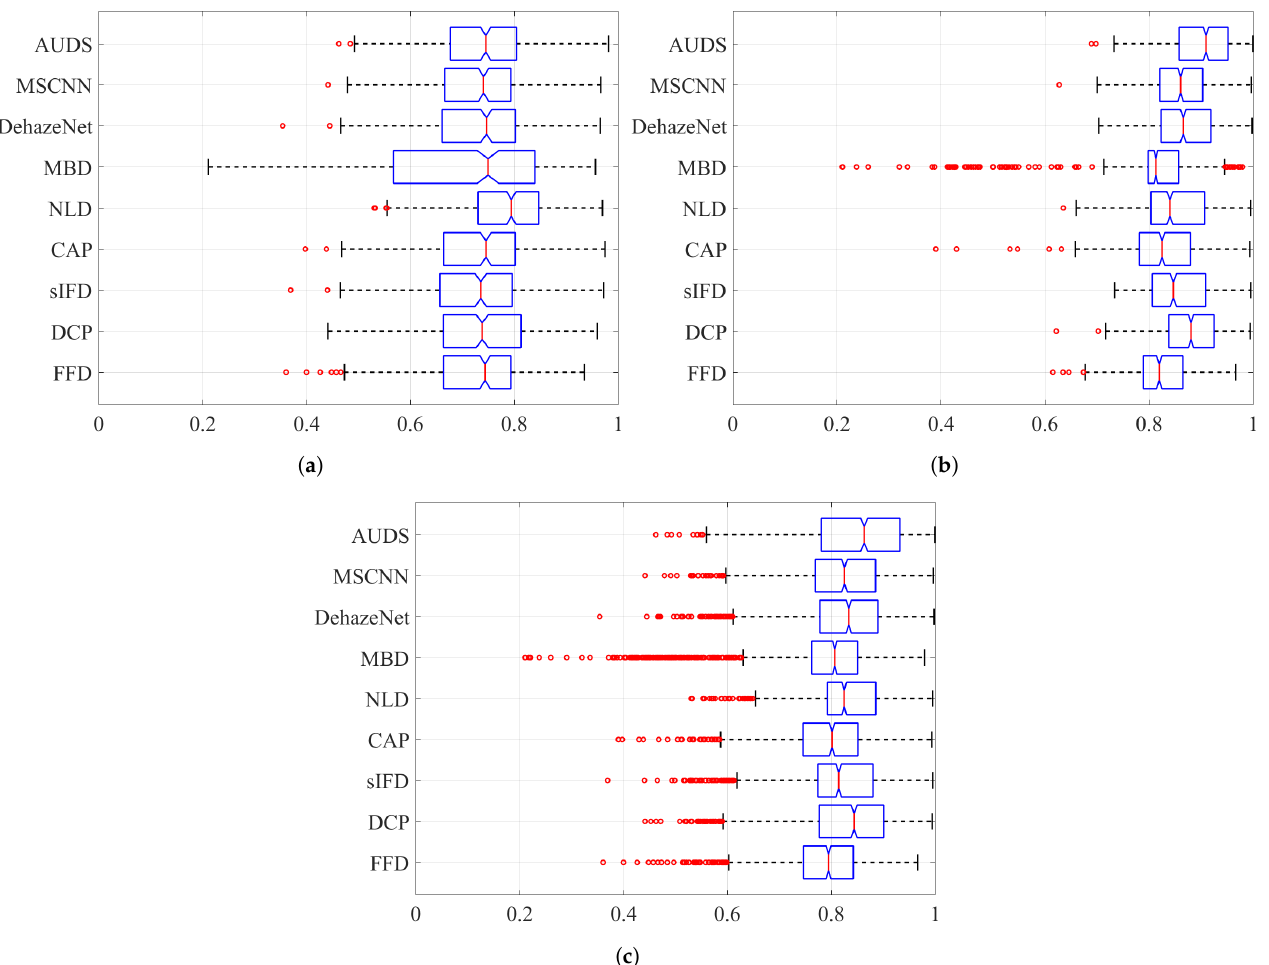
Figure 9. Boxplots of TMQI scores on different datasets when considering: ( a ) hazy images only, ( b ) haze-free images only, and ( c ) both hazy and haze-free